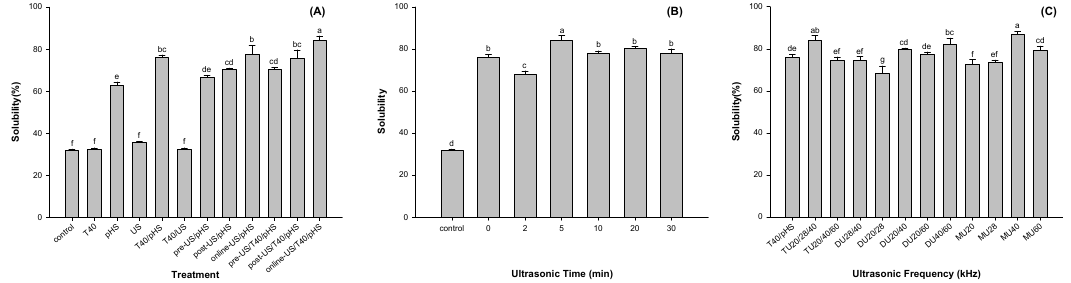
Figure 2. Effects of a combination of different modification methods ( A ) of mild thermal process (T40), Figure 2. E ff ects of a combination of di ff erent modification methods ( A ) of mild thermal process (T40), ultrasound (US: TU20/28/40 kHz) and pH shift (pHS), ultrasonic time ( B ) and ultrasonic frequency ultrasound (US: TU20 / 28 / 40 kHz) and pH shift (pHS), ultrasonic time ( B ) and ultrasonic frequency ( C